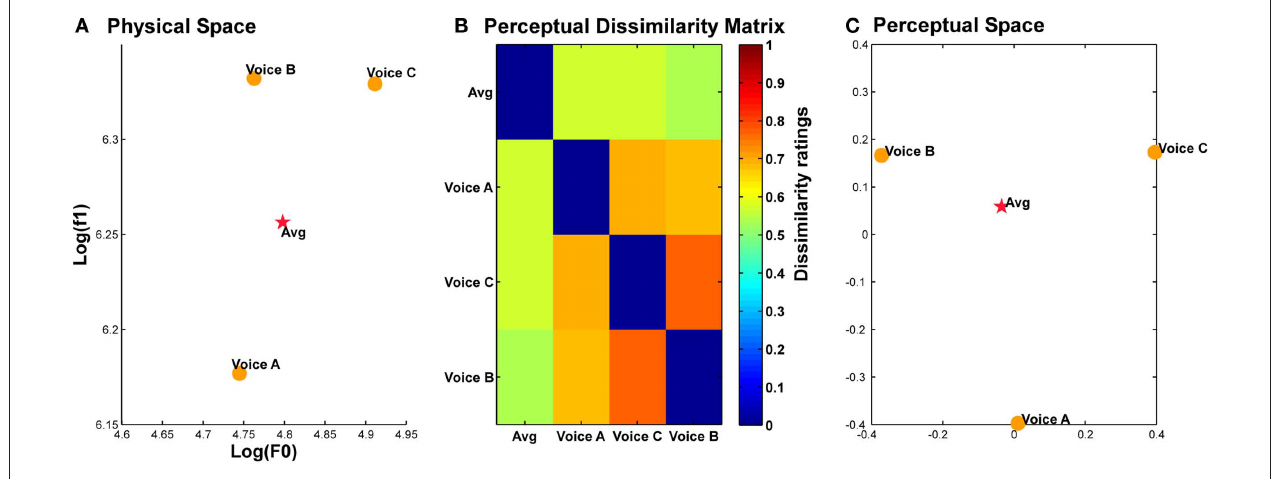
Figure 3 | Position of the average voice in physical and perceptual spaces. (A) . Position of the three original voice stimuli (A, B, and C) and